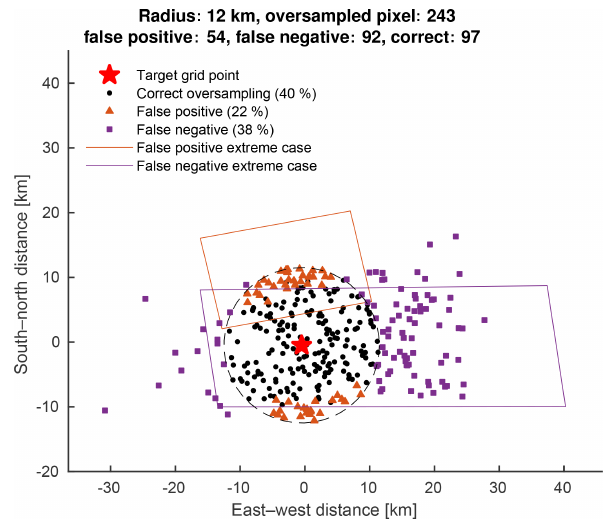
Figure 2. Centers of screened OMI pixels in 2005 over a target grid point (red star) near Denver, CO. Pixels that overlap with the target grid point with the pixel center falling within the averaging radius (dashed circle) are plotted as black points (correct oversam- pling, 40%). Pixels that overlap with the target grid point with the pixel center falling outside the averaging radius are plotted as pur- ple squares (false negative, 38%). Pixels that do not overlap with the target grid point with the pixel center falling in the averaging ra- dius are plotted as red triangles (false positive, 22%). Extreme cases of false positives or negatives are illustrated by OMI pixel quadrilat- erals. The percentages of correct oversampling, false positive, and false negative pixels are labeled in the